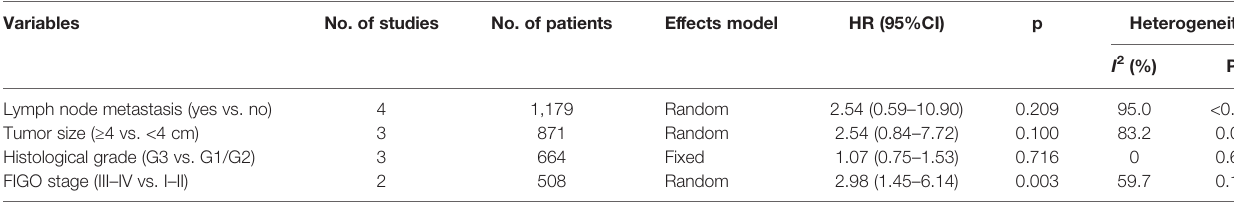
FIGO, International Federation of Gynecology and Obstetrics.